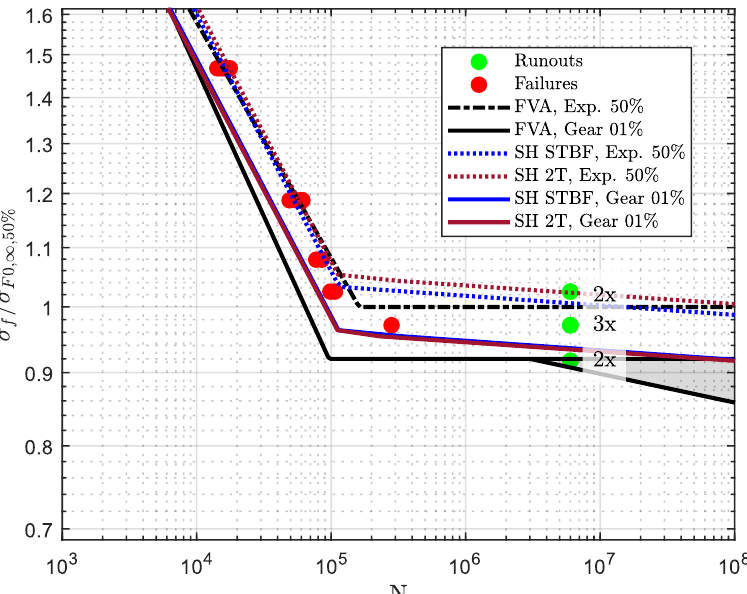
Figure 12. Comparison of the two estimation methods for exemplary campaign C from experimental FZG database [24].